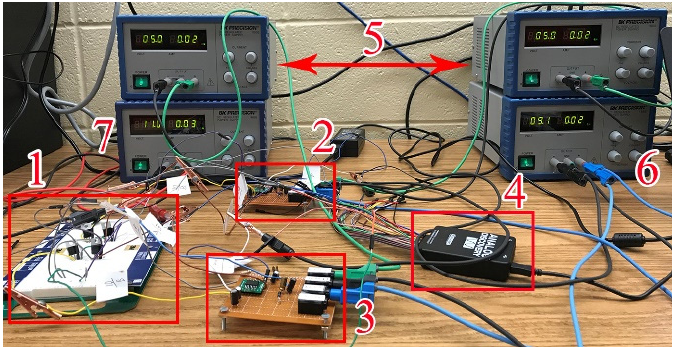
Figure 10. Prototype of GaN inverter without snubber circuits; 1: GaN inverter, 2: 1st gate driver, 3: 2nd gate driver, 4: Sending signals to the gate drivers, 5: 5 V DC of the gate drivers, 6: 9.1 V DC of the gate drivers, 7: Input V DC of GaN inverter.